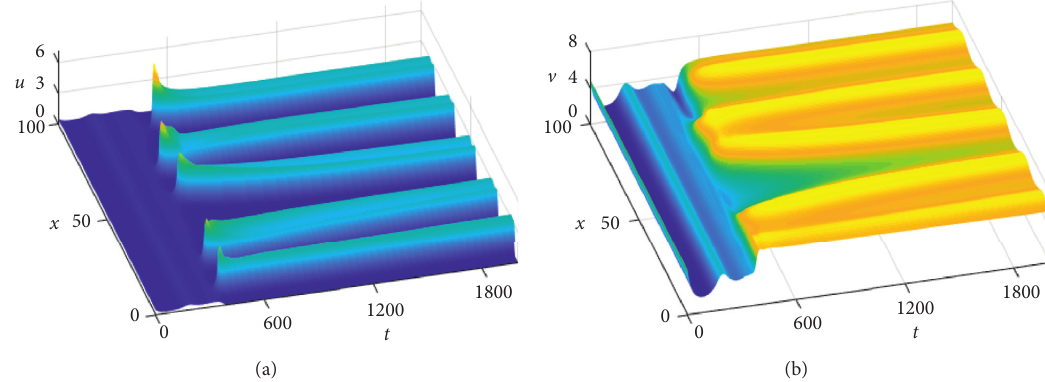
Figure 7: Numerical solutions of system (6a)–(6c): (a) prey population u and (b) predator population v , where r ( t, x ) � 0 . 9, K ( t, x ) � 10, a ( t, x ) � 0 . 8, b ( t, x ) � 0 . 8, e ( t, x ) � 0 . 7, c ( t, x ) � 0 . 02, δ ( t, x ) � 0 . 12, μ